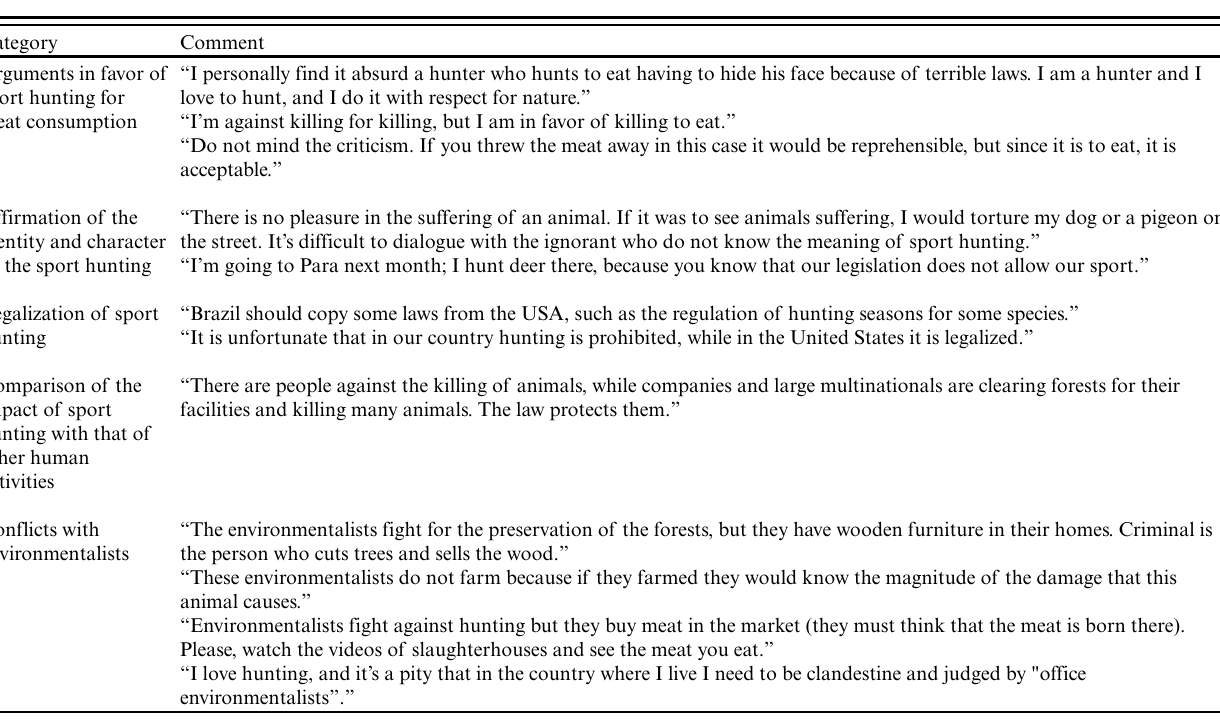
Table 4 . Main topics addressed by commentators in the discussions in favor of sport hunting in